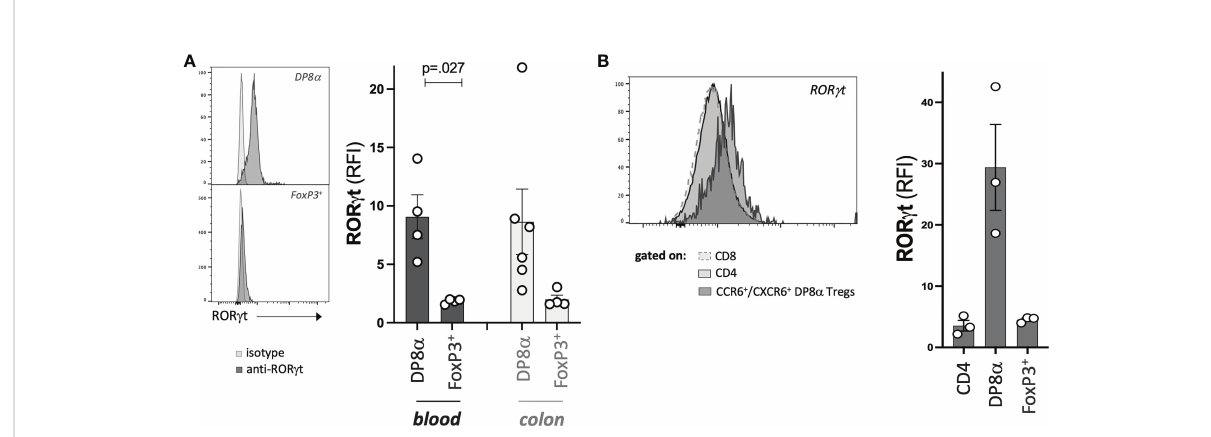
FIGURE 7 DP8 a Tregs express ROR g t. Expression of ROR g t by representative Treg clones (left) and all Treg clones (right) (A) , as well as indicated gated subsets from PBMCs (B) . Paired 2-sided t-tests were used for single comparisons, while one-way ANOVA followed by Dunn ’ s multiple comparison tests were performed for 7B, p<.05 was considered statistically signi fi cant.